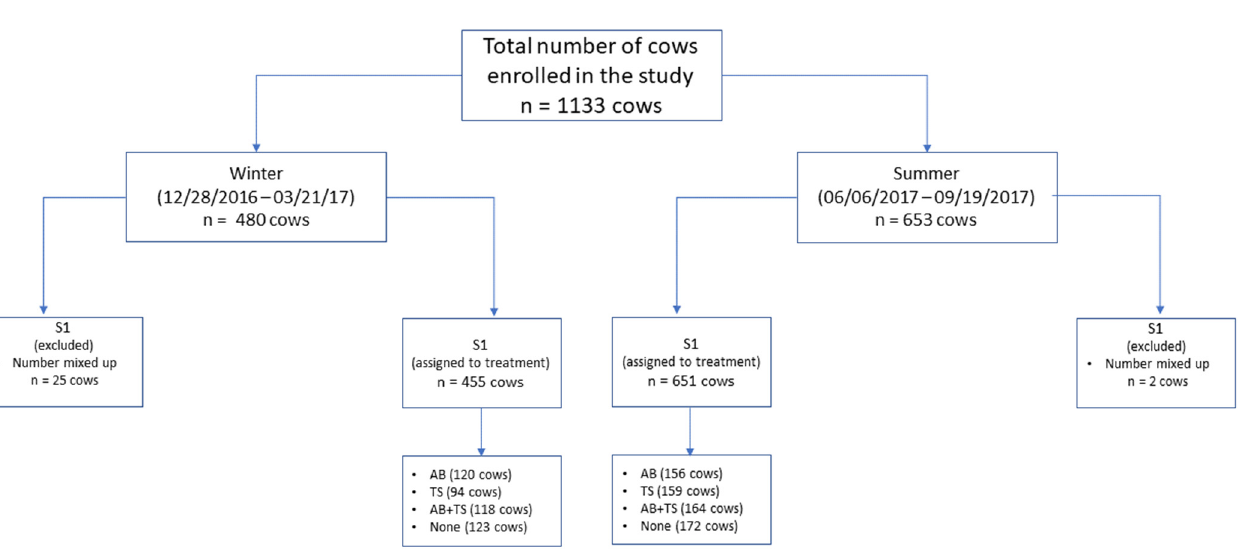
herds, and 86 and 207 from the two Kings County herds. Over the study period, a